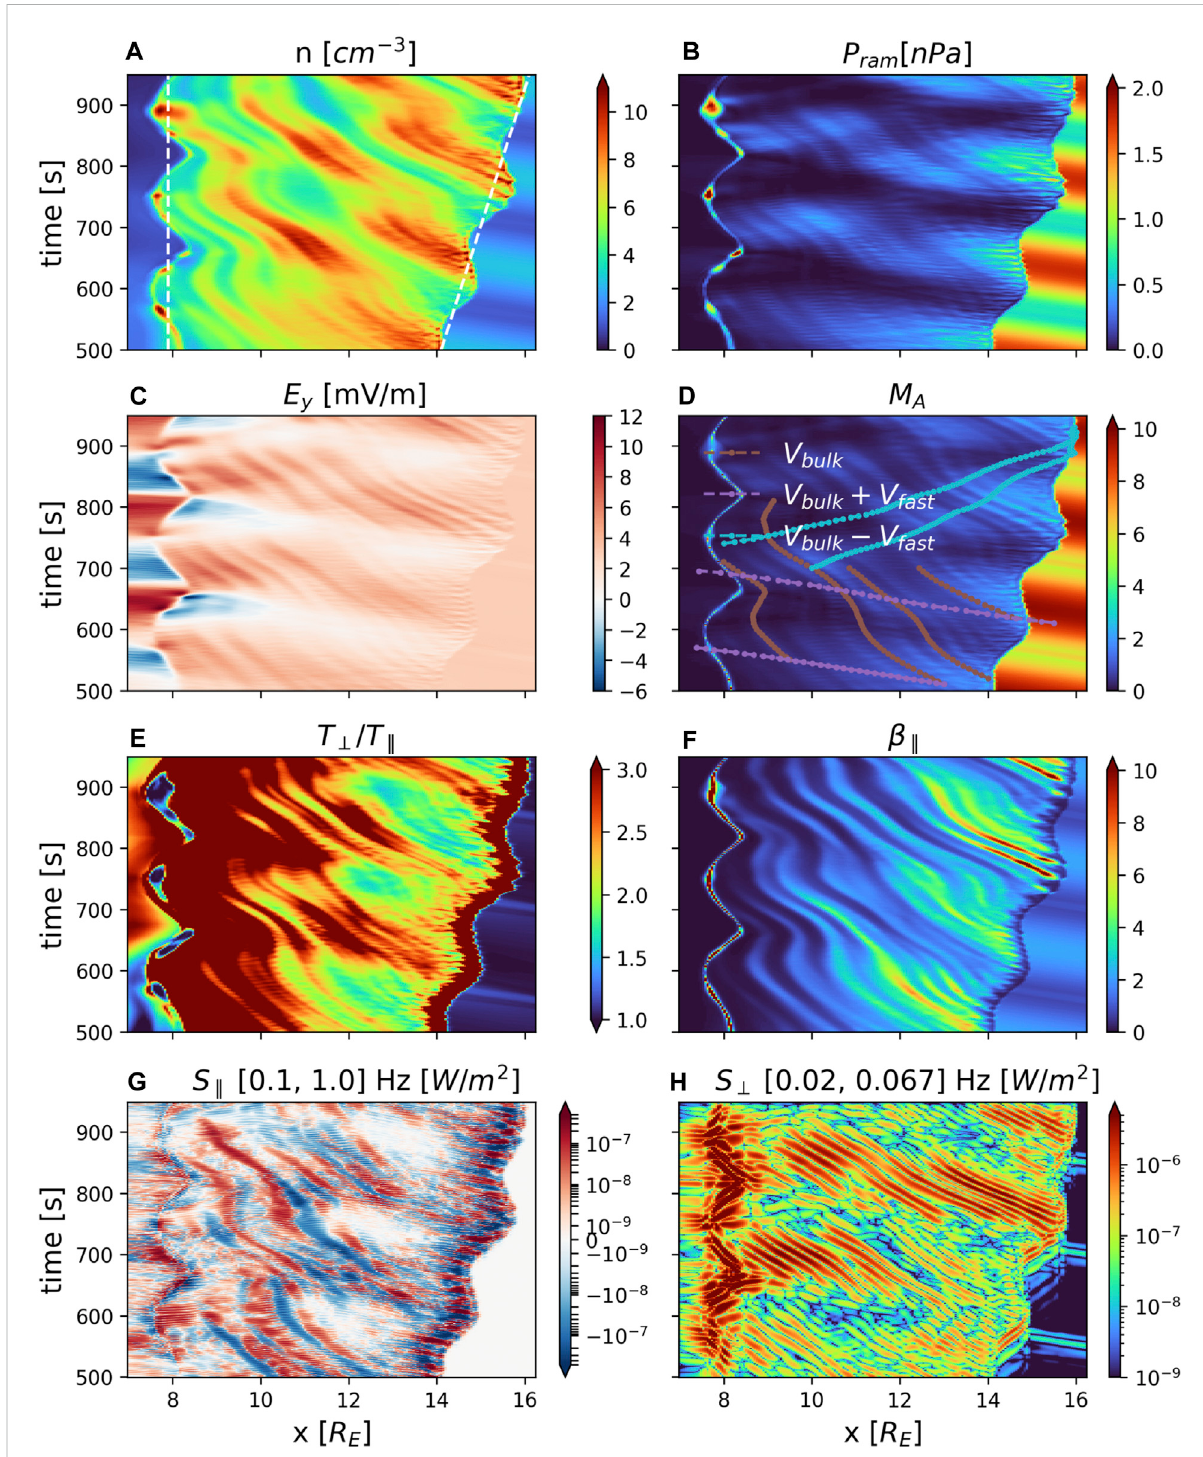
FIGURE 7 Space-time fi lled contours of density n , ram pressure P ram , electric fi eld E y , Alfvén Mach number M A , anisotropy, β (cid:1) , and parallel and perpendicular Poynting fl uxes in two frequency bands along the subsolar line from x = 7 to 16.2 R E during t = 500 – 946s. The dashed lines in (A) represent the mean location of the discontinuities. The dotted lines in (D) represent wave tracking starting from multiple locations and times with local bulk velocities V bulk in brown and additional local fast magnetosonic velocities V fast in purple (parallel to V bulk ) and cyan (anti-parallel to V bulk ),respectively.Asymmetriclogscalewithlinearthresholdat10 – 9 W/m 2 isappliedfor (E) .Thearrowsincolorbarsrepresentsaturatedcolorswith magnitudes outside the chosen